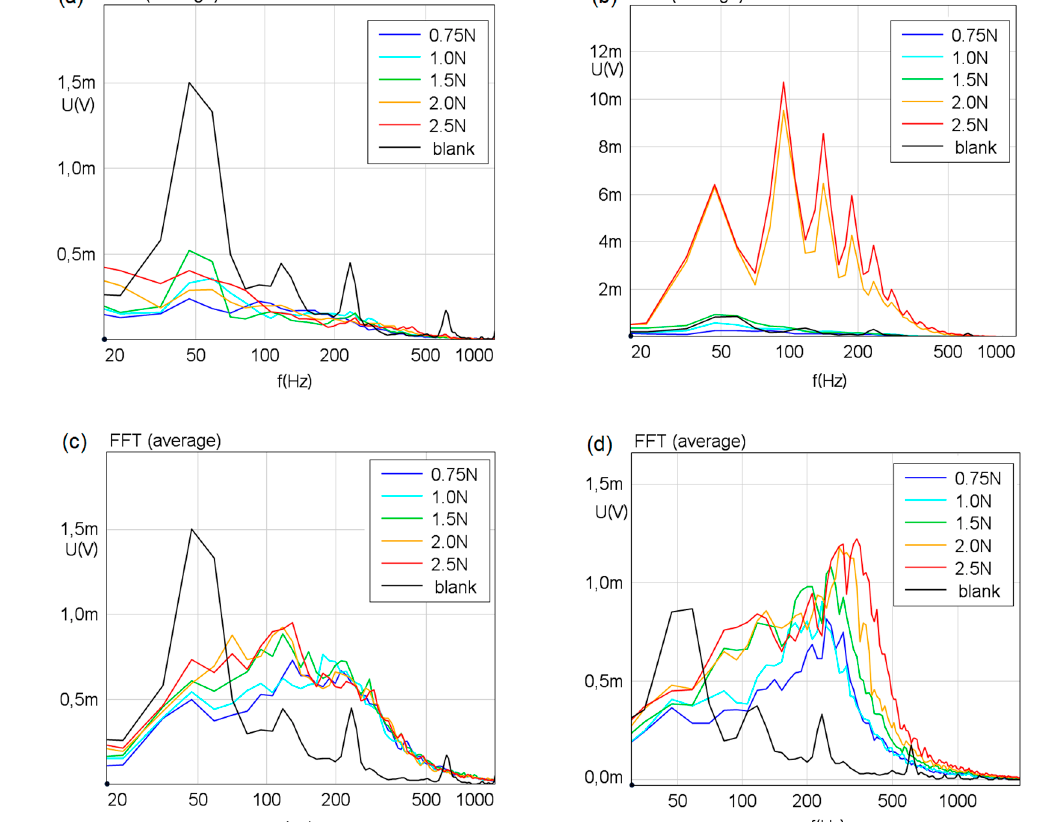
Figure 8. Displayed are fast Fourier transformations for ( a , b ) S1 and ( c , d ) S2 for the ( b , d ) forward and ( a , c ) backward motion, for increasing normal forces. The black curve is a baseline measurement, i.e., without finger-surface contact.